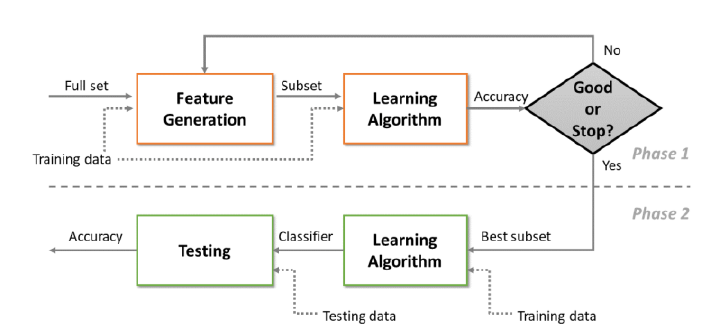
Fig. 3. Applying Wrapper Methods for Feature